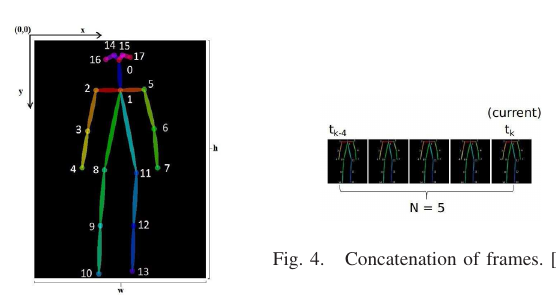
Fig. 4. Concatenation of frames.